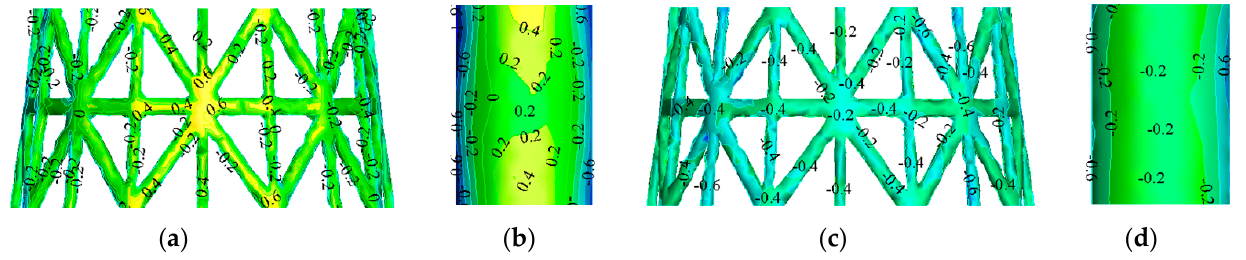
Figure 24. Mean wind pressure coefficient distribution on the 50 m layer: ( a ) Windward side of the grid structure; ( b ) Windward side of the core tube; ( c ) Leeward side of the grid structure; ( d ) Leeward side of the core tube.